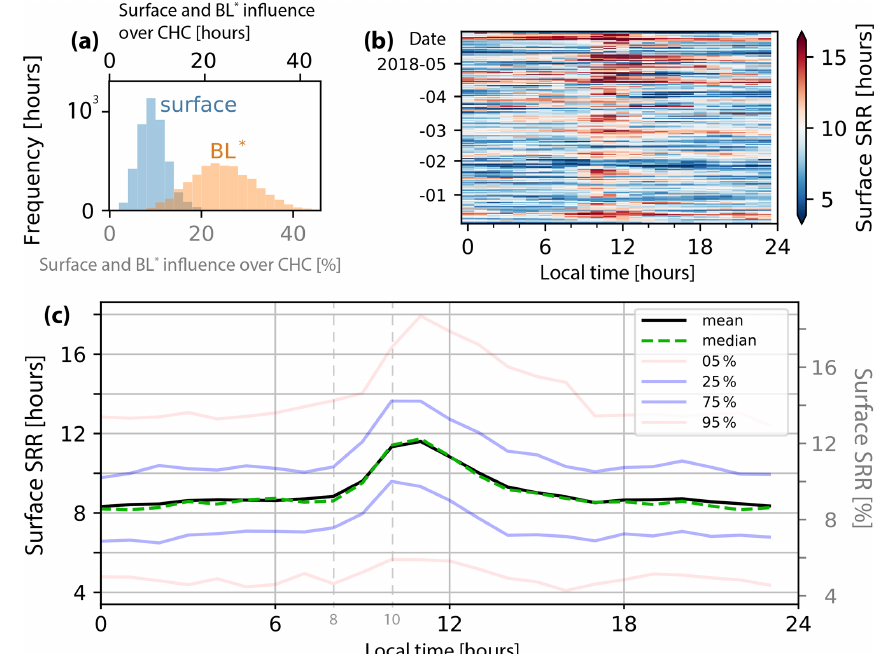
Figure 5. Panel (a) is a frequency histogram showing the percentage (and residence time in hours – upper x axis) of air sampled at CHC during each modelled hour that was in contact with the surface ( S SRR , blue; Eq. 2) or located within the pseudo-PBL (PBL ∗ Eq. 3). Panel (b) shows the surface influence (as a residence time) for every day of the modelled period as a function of local time. Panel (c) shows the diurnal mean and median as well as the 5th, 25th, 75th and 95th percentile ranges of the SRR surface influence. The left y axis is the residence time, and the right y axis is the percentage